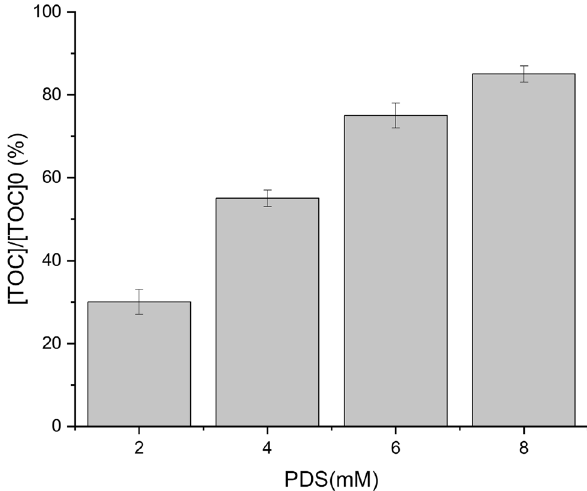
Fig. 10 TOC of AMR solution treated in ZVI/PDS system of different Fig. 11 HPLC–MS ESI total ion chromatograms of AMR solu- PDS concentrations. Experimental conditions: [AMR] = 50 mg/L, tion treated in ZVI/PDS system with a retention time of about 0 [TOC] = 28.8 mg/L, [PDS] = 2–8 mM, [ZVI] = 15 mM, Temp. = 25 °C, 3 min. Experimental conditions: [AMR] 0 0 0 pH 7.0, reaction time = 20 min [ZVI] = 15 mM, Temp. = 25 °C, pH 7.0, reaction time = 5 0